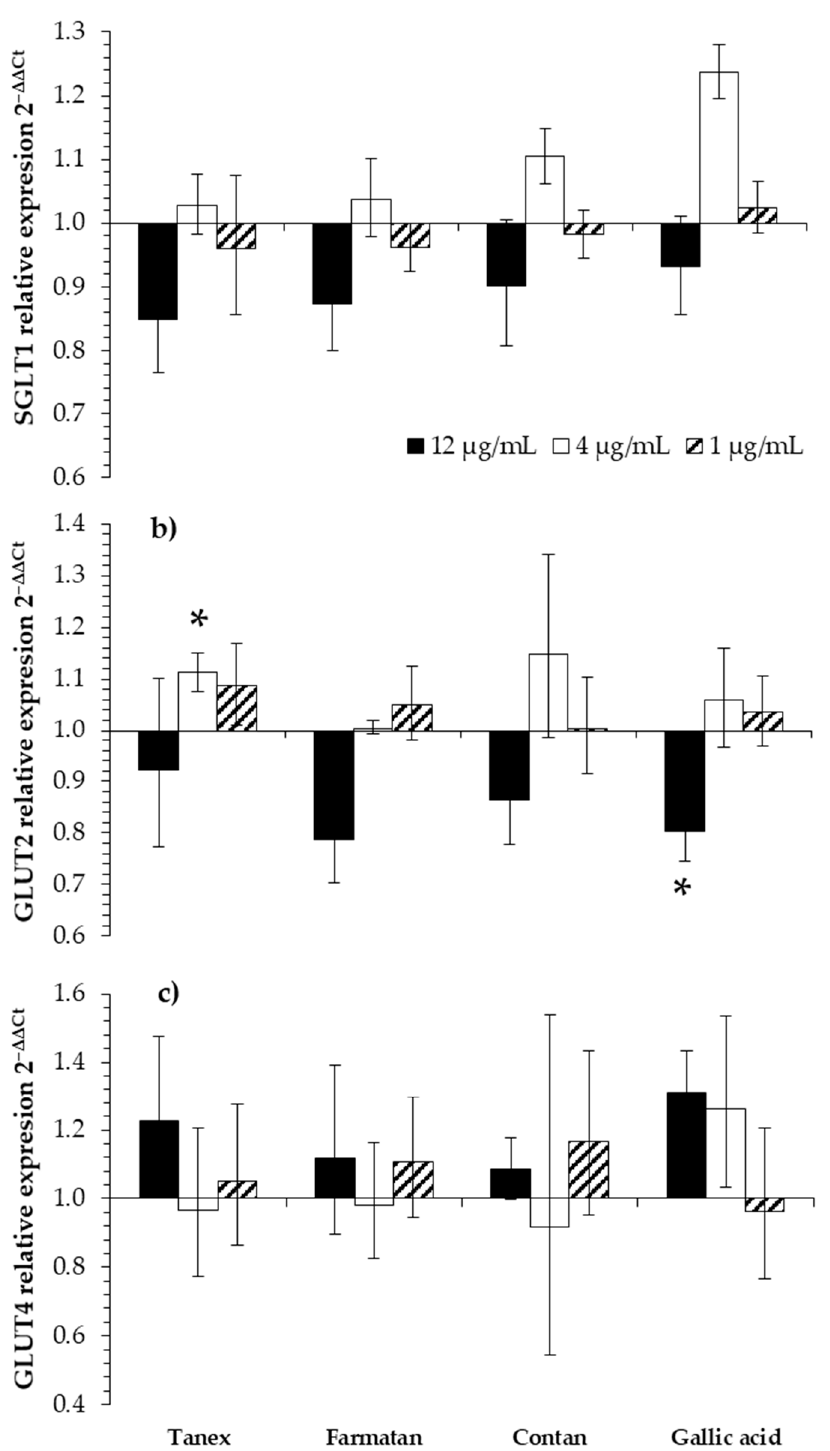
Figure 2. Analysis of SGLT1, GLUT2, and GLUT4 gene expression in CLAB cells exposed to wood extracts for 6 h. ( a ) SGLT1; ( b ) GLUT2; ( c ) GLUT4. Results presented as mean 2 − ∆∆ Ct expression relative to control of independent triplicates ± error of expression calculated from standard deviations. * represents statistically significant differences in gene expression of SGLT1, GLUT2 and GLUT4 between different HT concentrations and control (without added additive) at p ≤ 0.05.